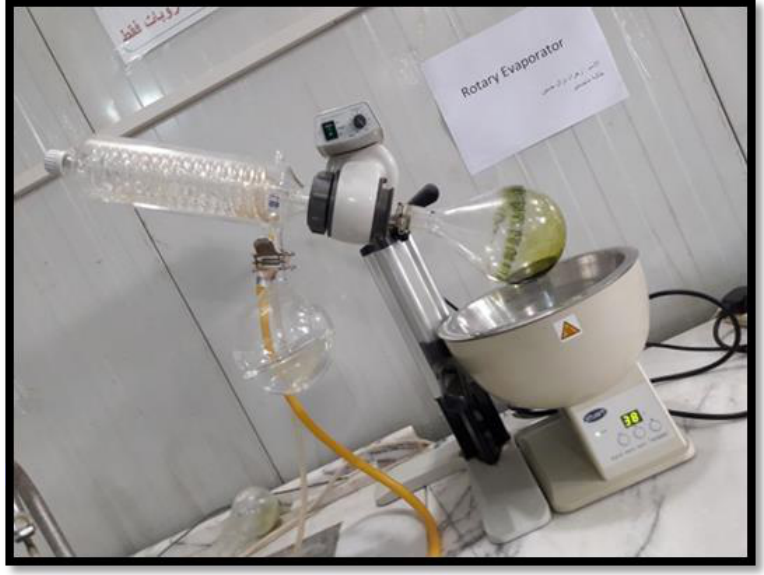
Fig. 2. Photographic pictures of Rotary